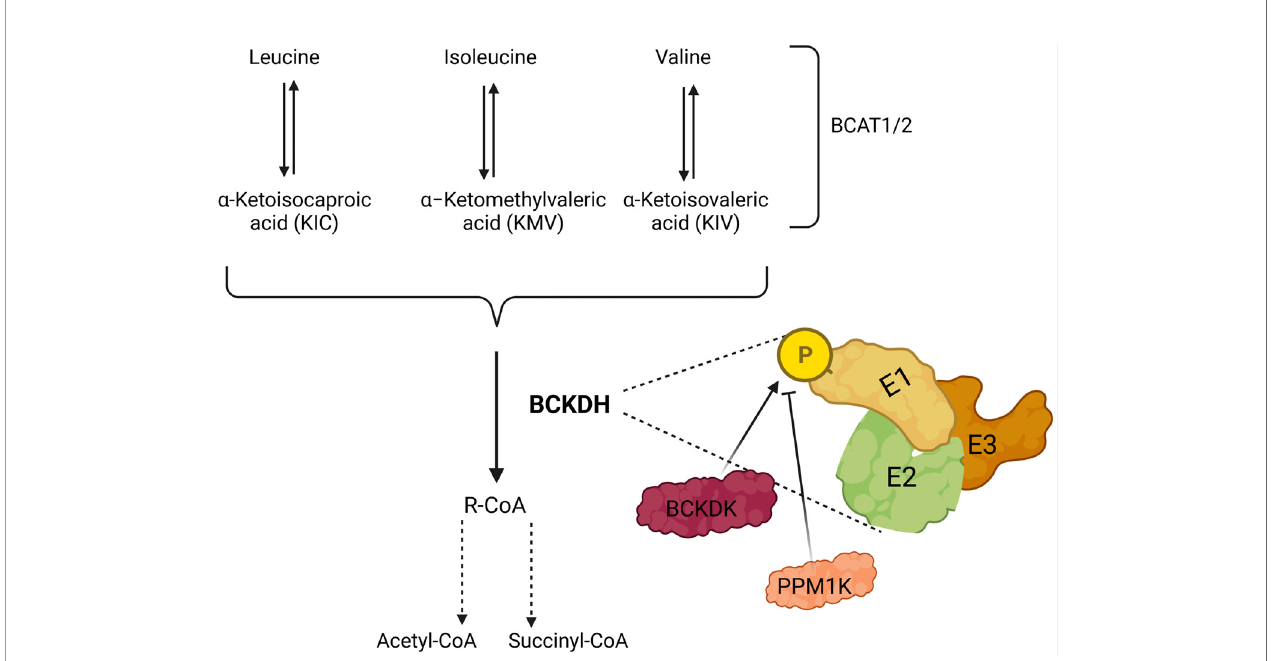
FIGURE 2 | Illustration showing catabolism of branched-chain amino acids (BCAAs). BCAAs are deaminated by BCAA transaminases 1 and 2 (BCAT1/2) reversibly to form branched-chain keto acids (BCKA); leucine, isoleucine, and valine generate a -ketoisocaproate (KIC), a -keto- b -methylvalerate (KMV) and a -ketoisovalerate (KIV), respectively. BCKAs are further cleaved by the branched-chain a-keto acid dehydrogenase complex (BCKDH) to form branched-chain acyl-CoA (R-CoA) irreversibly, which may also go through several enzymatic steps to form acetyl-CoA and/or succinyl-CoA. BCKDH complex consists of three subunits E1, E2, and E3, and phosphorylation by branched-chain keto acid dehydrogenase kinase (BCKDK) inhibits the activity of BCKDH. In addition, PPM1K (protein phosphatase, Mg 2+ /Mn 2+ -dependent 1K) removes the phosphate residue and inhibits the activity of BCKDK, which results in the activation of